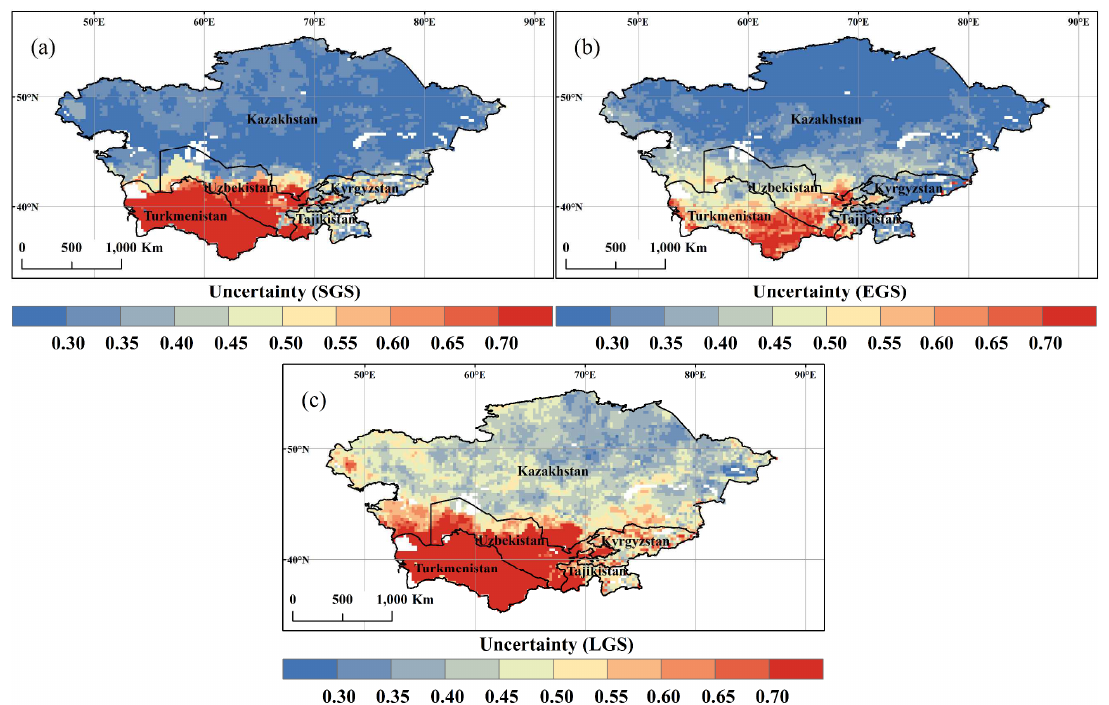
Figure 10. Spatial distribution of trends in ( a ) SGS, ( b ) EGS, and ( c ) LGS for the period 1982–2014.